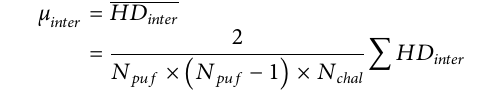
Frontiers in Electronics |